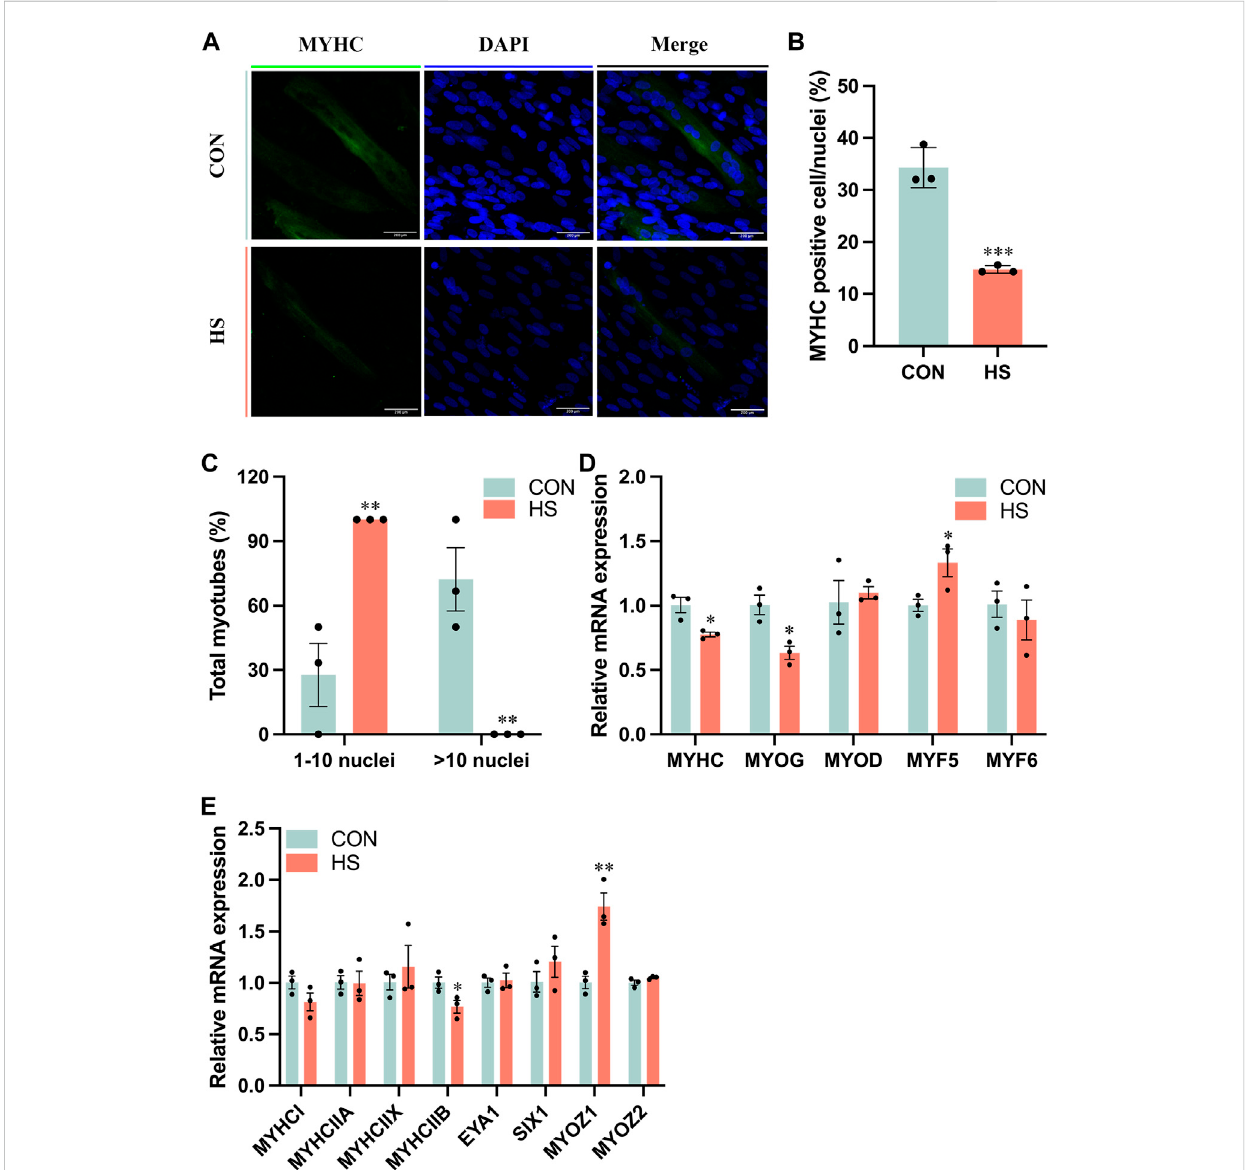
Heat stress inhibited the differentiation of myoblasts. (A) Representative images of MYHC by immuno fl uorescence in myoblasts during differentiation. Scale bar, 200 μ m. (B) The MYHC-positive cells of myoblasts. (C) The total myotubes of myoblasts. (D) RT-qPCR detected the expression of thedifferential genes. (E) RT-qPCR detected the expression ofthe genes related to the muscle fi ber type. All data are shown as the mean± SEM (n = 3, * p < 0.05; ** p < 0.01, *** p < 0.01).